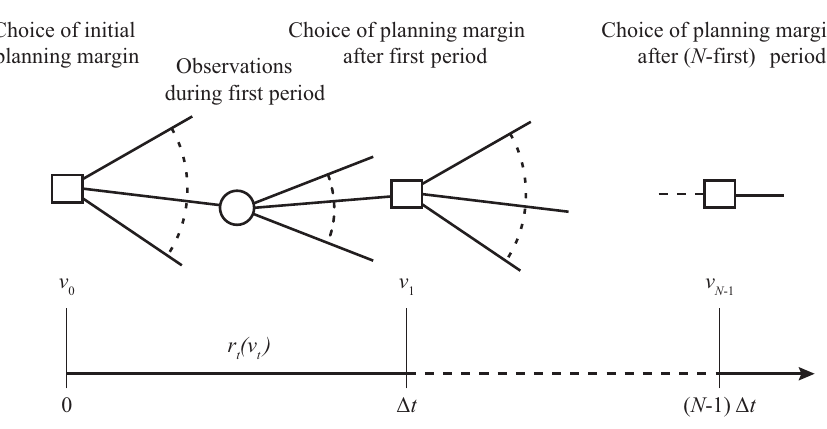
Figure 3. Sequential planning process in risk-based flood protection planning. Squares stand for protection decisions and circles for obser- vations of annual maximum discharge. The curved dotted lines stand for the continuous spectrum of possible decisions and observations. Adapted from Dittes et al.